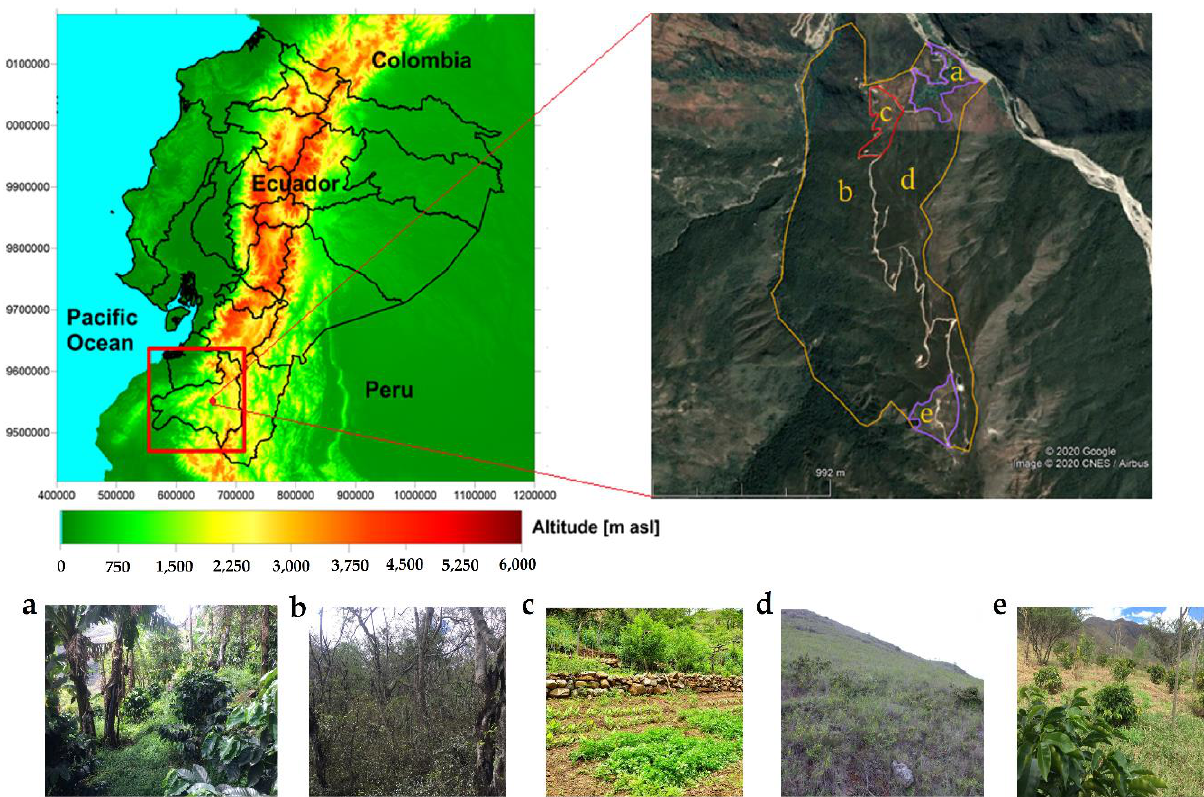
Figure 1. Digital elevation model (DEM) of continental Ecuador (left) and study area (right). Below: different land-use changes (L-UCH) classes analyzed in this study, where ( a ) CoAS = coffee in an old agroforestry system; ( b ) SDF = disturbed seasonally dry forest; ( c ) OCA = organic crop area; ( d ) GLd = grassland; and ( e ) CyAS = coffee in a young agroforestry system.